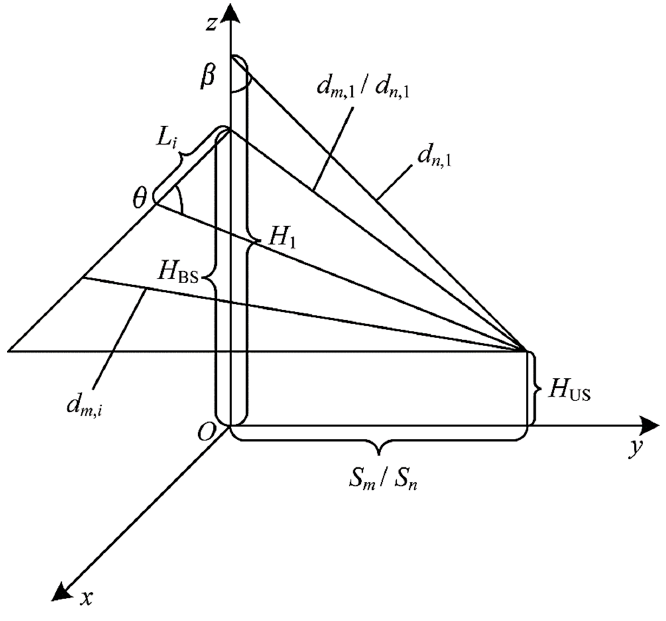
Figure 5. Precoding scheme beam pattern.